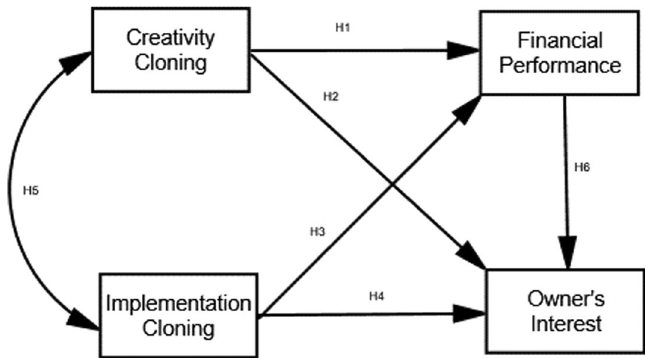
Fig. 1 Framework of the study